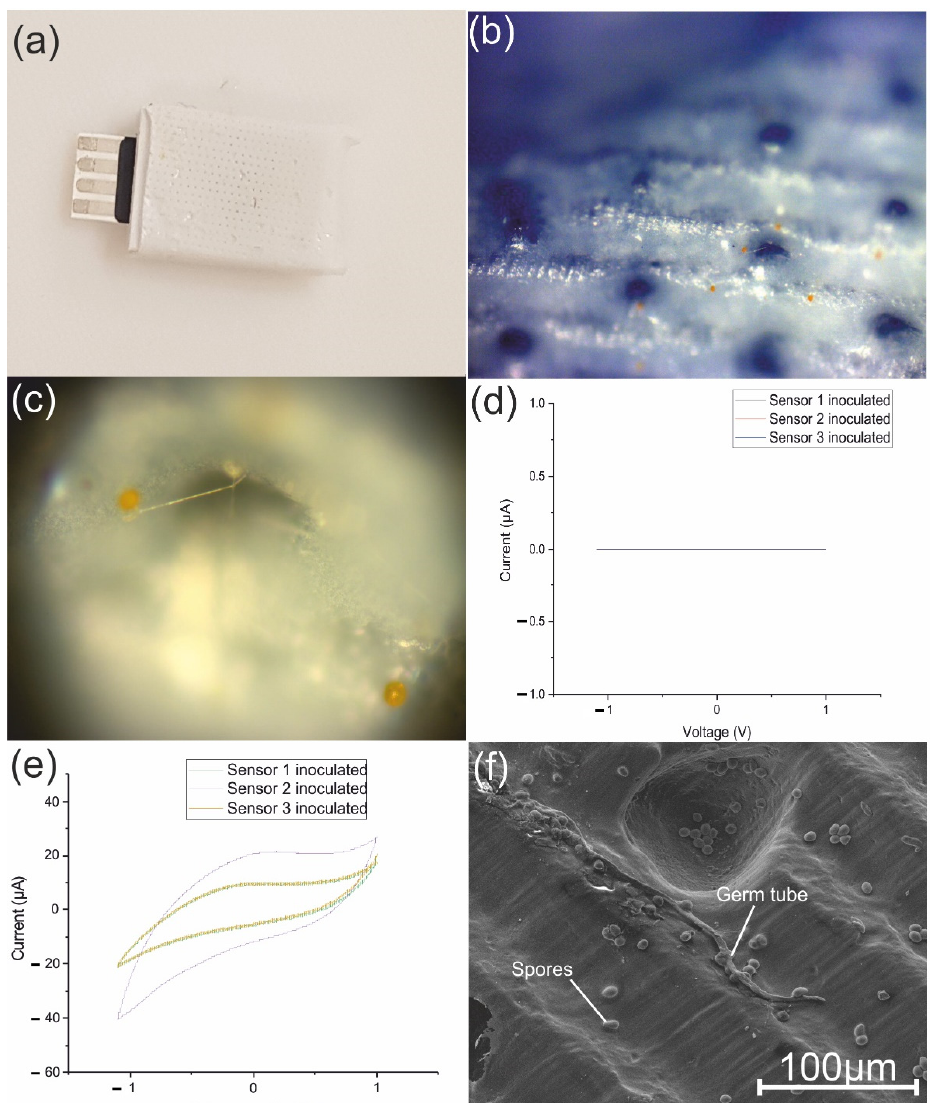
Figure 15. ( a ) Biosensor assembly, ( b ) top surface of biosensor inoculated with P. s . f. sp . tritici spores, ( c ) underneath surface of the top layer of the biosensor showing a germinated P. s. f. sp. tritici spore, ( d ) CV curve obtained at 24 h, ( e ) CV curve obtained after 72 h, ( f ) SEM image of P. s. f. sp. tritici spores and a germ tube growth on the surface of the biosensor.